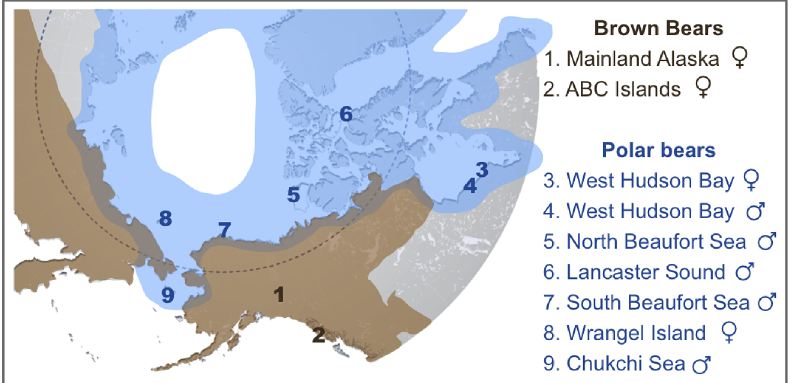
Figure 1. Map showing the approximate current geographic ranges of brown bears (brown) and polar bears (blue). Numbers indicate the geographic location of origin of two brown bears and seven polar bears analyzed here. An American black bear from central Pennsylvania was also sequenced as part of this study. Shotgun data amounting to 4–6 6 coverage for polar bears and 11–12 6 coverage for brown and black bears (Table S2) was aligned to the current distribution of the polar bear genome